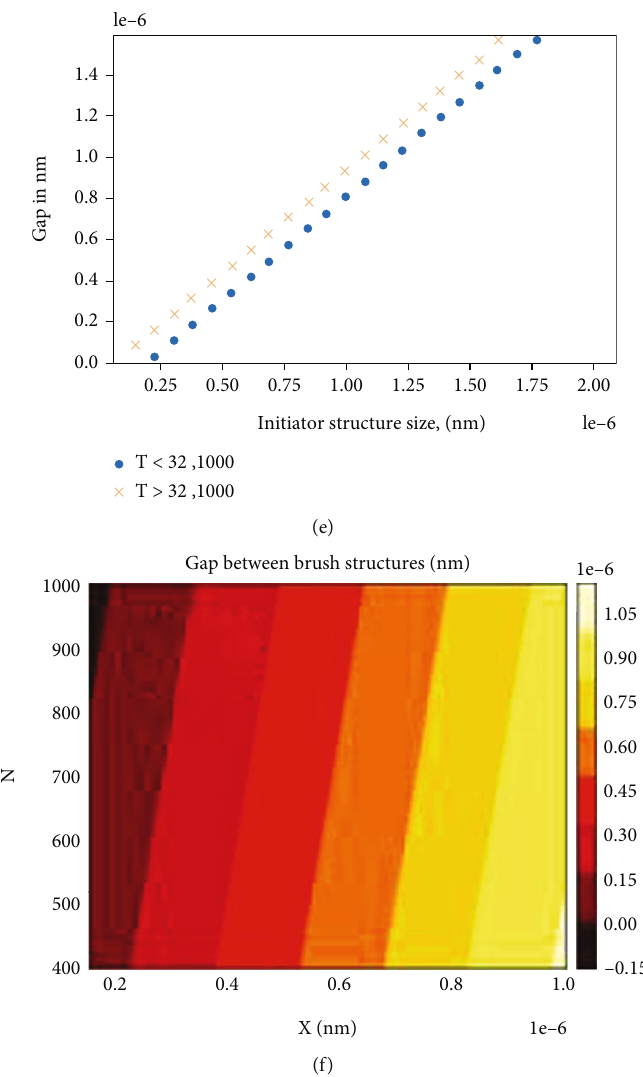
Figure 12: Plot of the gap between periodically placed polymer brush structures versus the initiator structure size x; (a) below the LCST for di ff erent degrees of polymerization; (b) above the LCST for di ff erent degrees of polymerization; (c) below the LCST for di ff erent densities; (d) above the LCST for di ff erent density; (e) comparison for below the LCST and above the LCST for N = 1500 ; and (f) contor plot of the gap as a function of both N and x while density kept constsnt at